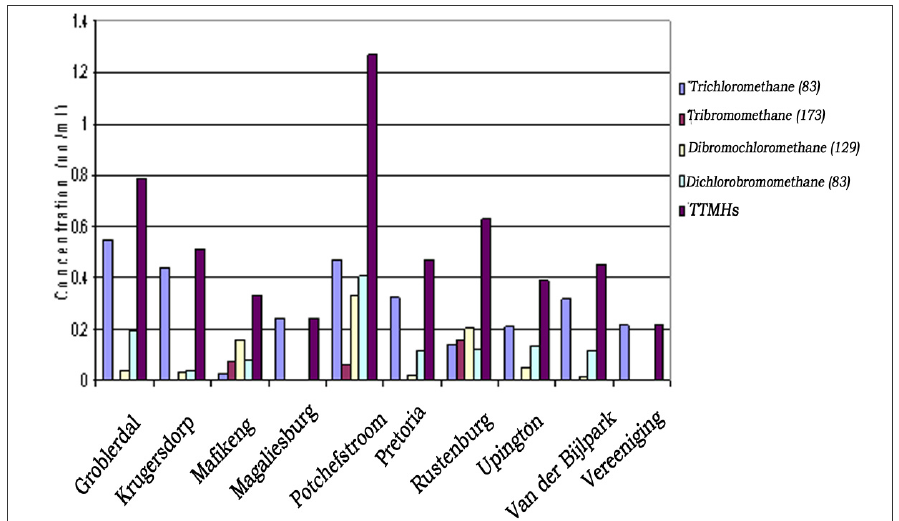
Preliminary results of ten of the 31